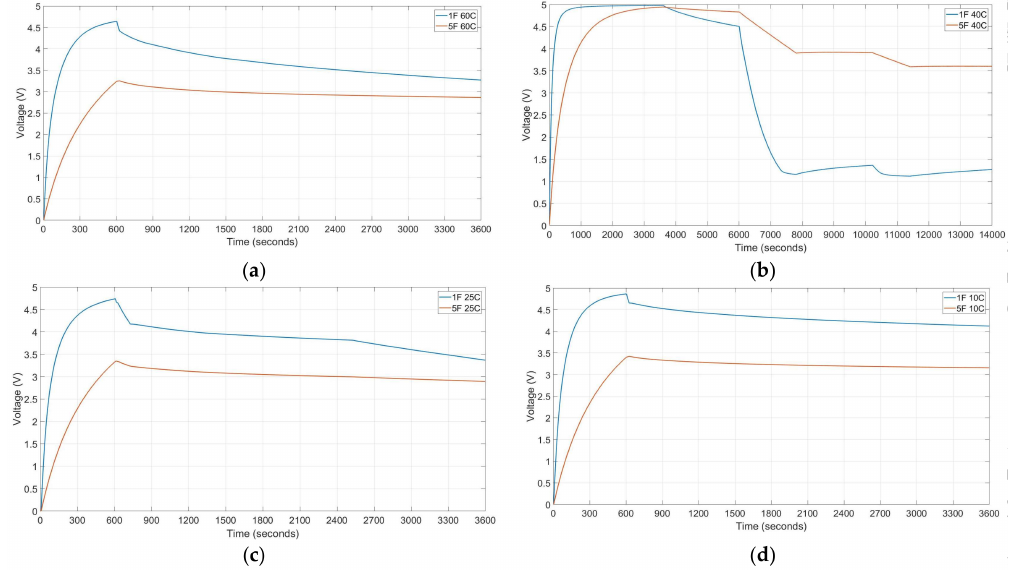
Figure 5. Charge and discharge profiles of 1 and 5 F supercapacitor at different test